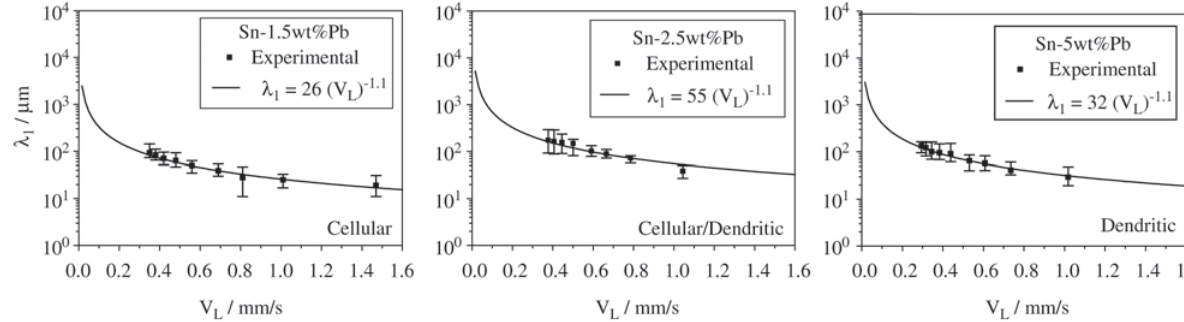
Figure 3. Cellular/Dendritic spacings as a function of tip growth rate.